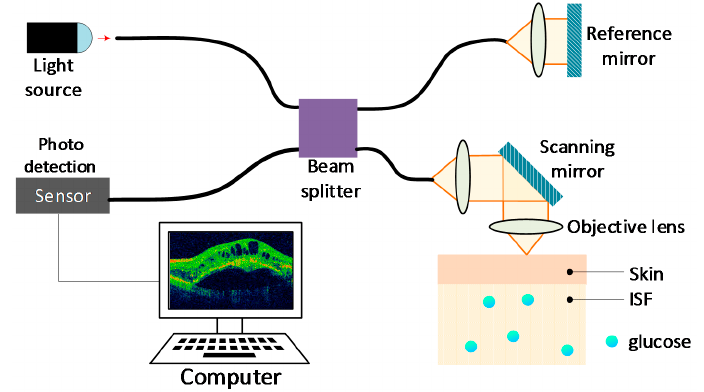
Figure 8. Principle of OCT scanning for glucose monitoring. Table 8. Advantages and disadvantages of Optical Coherence Tomography.